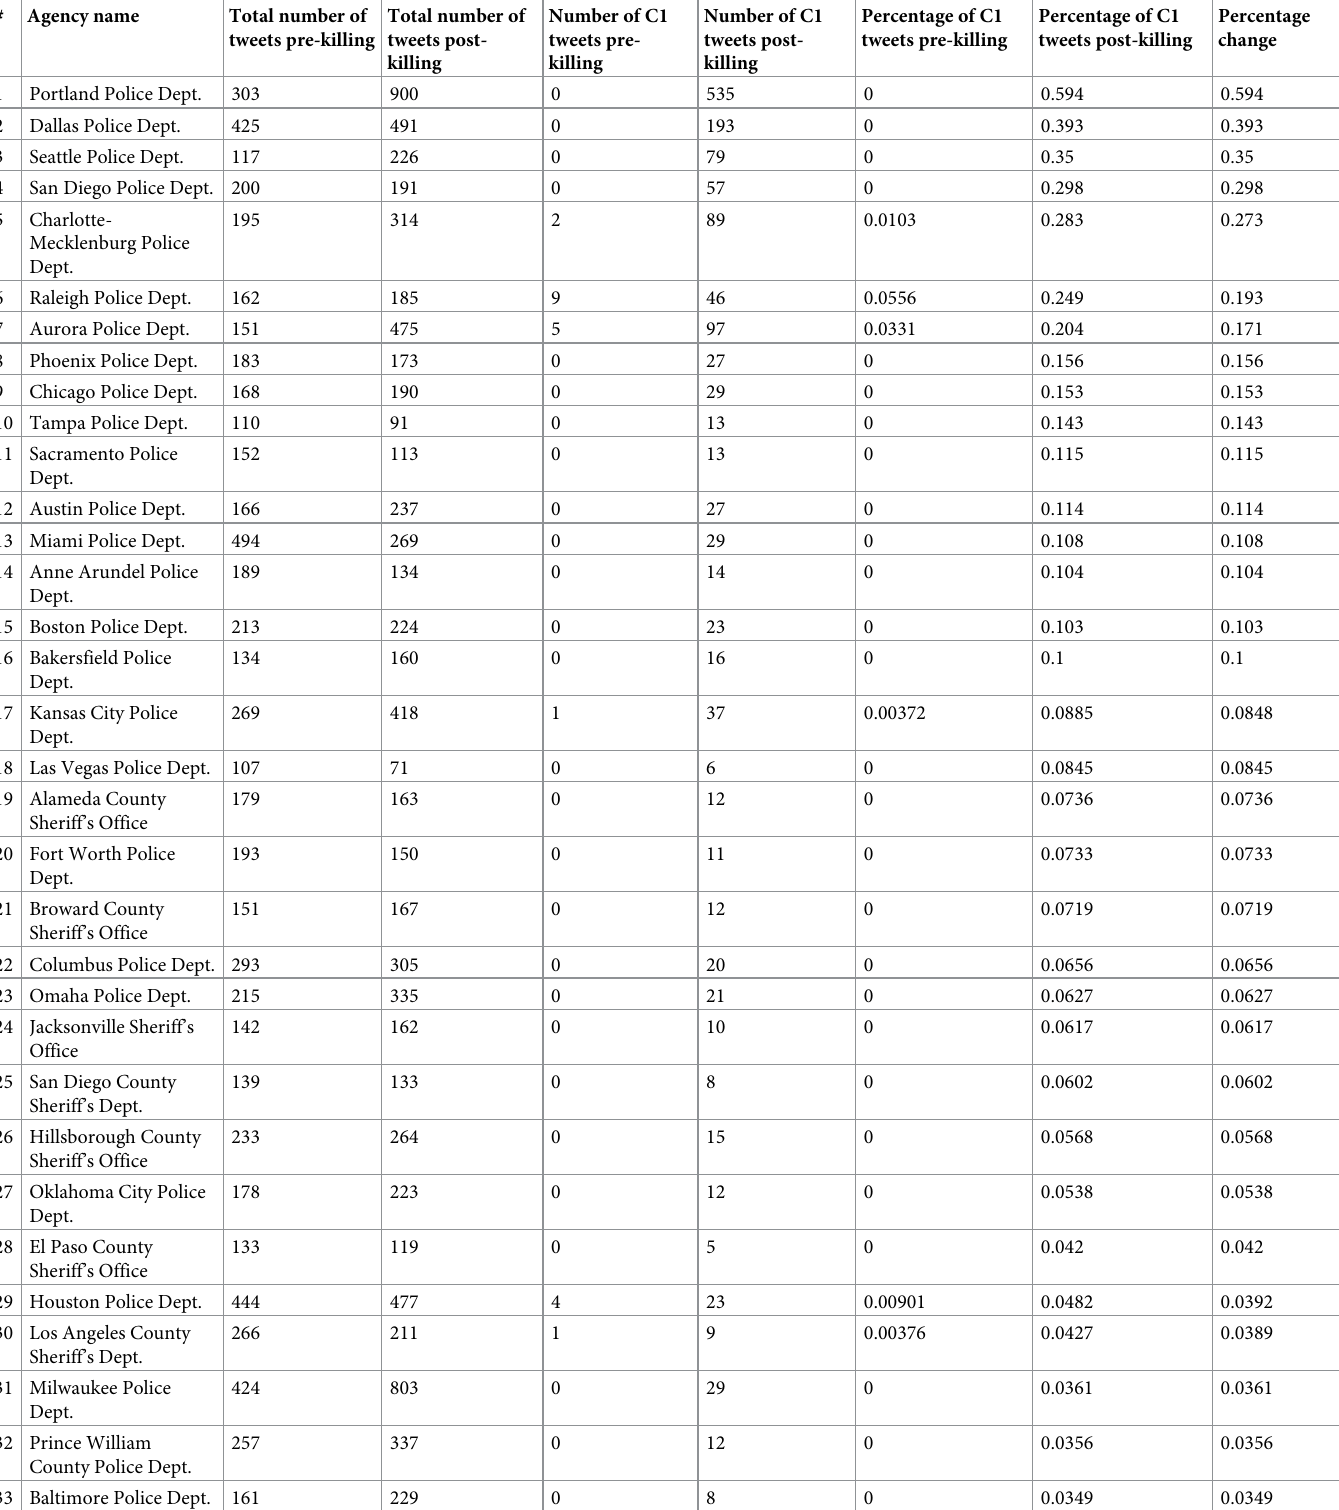
Table 9. Agencies (in the higher-use group) ranked by the increase in posting category 1 (civil unrest related) tweets before and after the